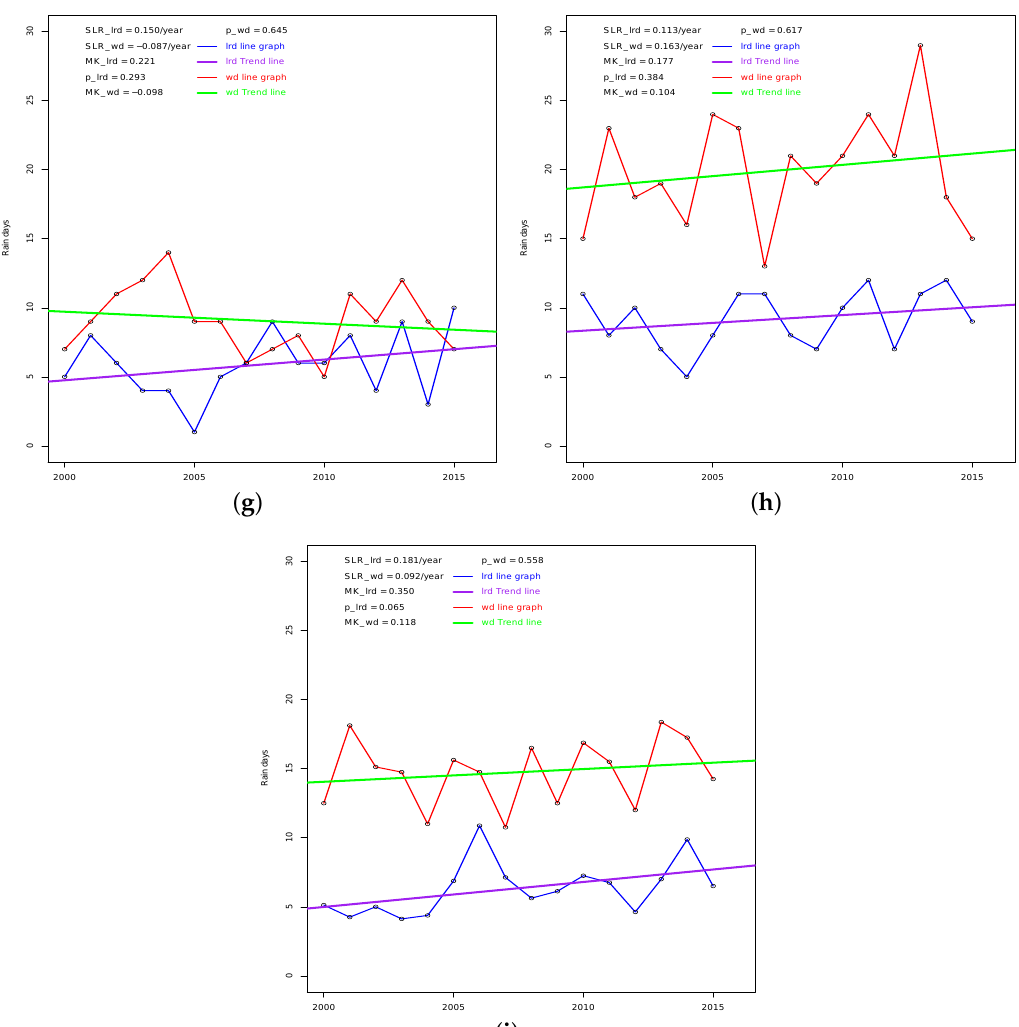
Figure 3. The figure is for MAM light rain days and MAM wet days for each of the study locations with ( i ) indicating the average over the study region. “ SLR _lrd” is the regression rate for light rain days; “ SLR _wd” is the regression rate for wet days; “ MK _lrd” is the Mann–Kendall trend score for light rain days; “ MK _wd” is the Mann–Kendall trend score for wet days; “p_lrd” is the significance level for light rain days; “p_wd” is the significance level for wet days; “lrd” means light rain days; and “wd” is wet days. ( a ) Entebbe; ( b ) Jinja; ( c ) Kamenyamigo; ( d ) Kituza; ( e ) Makerere; ( f ) Namulonge; ( g ) Ntusi; ( h ) Tororo; ( i )